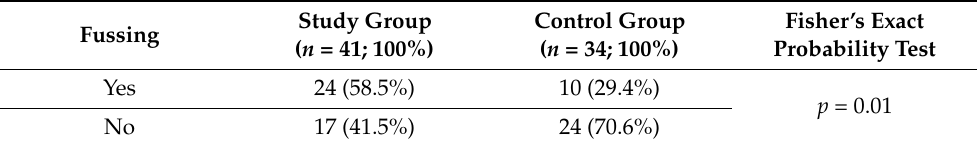
Table 4. Distribution of fussing while consuming meals by children in the Study Group and the Control Group (question II/7).